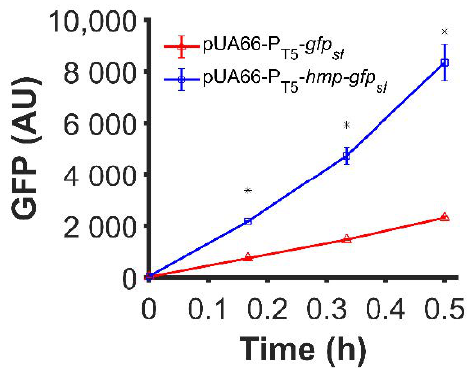
Figure 1. Hmp translational fusion increased expression of sfGFP from an IPTG-inducible promoter under normal growth conditions. Data shown are median GFP signal of wild-type E. coli harboring pUA66-P T5 - gfp sf (pSA21) (red) and pUA66-P T5 - hmp-gfp sf (pJR05) (blue) cultures measured by flow cytometry. Data are the means of three independent replicates, and error bars represent the standard errors of the means. Asterisks (*) indicate statistically significant differences between pUA66-P T5 - gfp sf (red) and pUA66-P T5 - hmp-gfp sf (blue) as assessed using t-tests and a significance threshold of p - value ≤ 0.05.